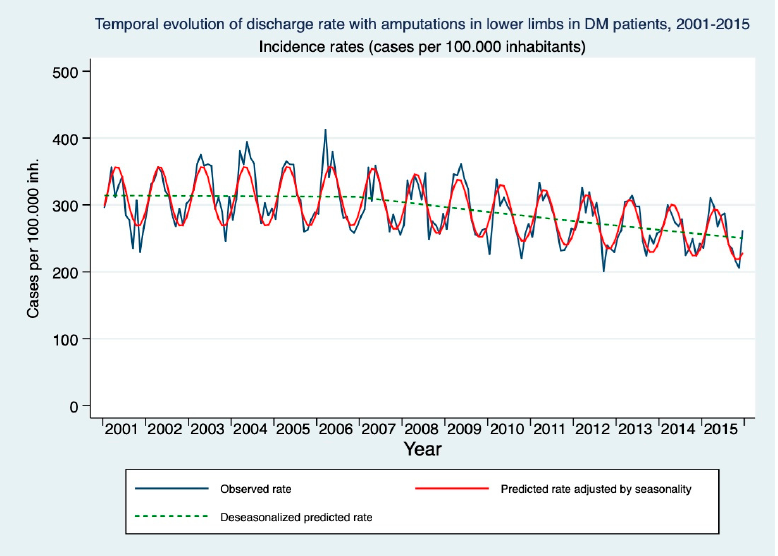
Figure 3. Modeling of the temporal evolution of the rate of hospital discharges with lower limb amputations in people over 18 years of age with DM in the period